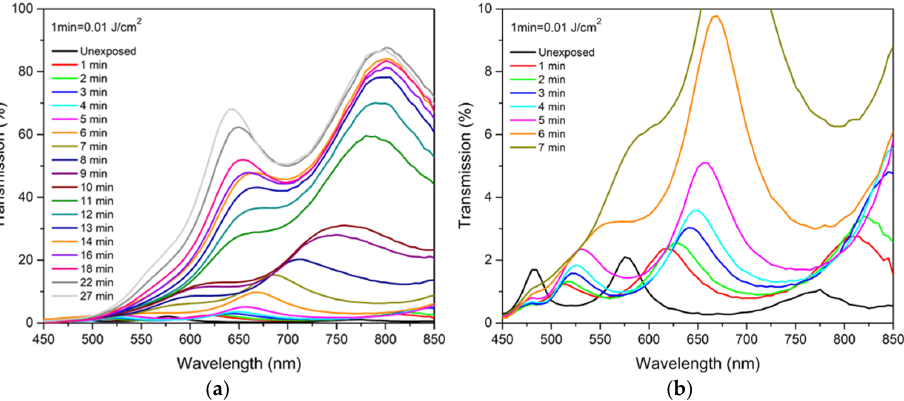
Figure 4. ( a ) Evolution of the spectral dependence of the transmission of the As 2 S 3 /Ag structure for different dosages of exposure at 470 nm—overall process. ( b ) Evolution of the spectral dependence of the transmission of the As 2 S 3 /Ag structure for different dosages of exposure at 470 nm—highlights the early ‐ stage mechanisms.